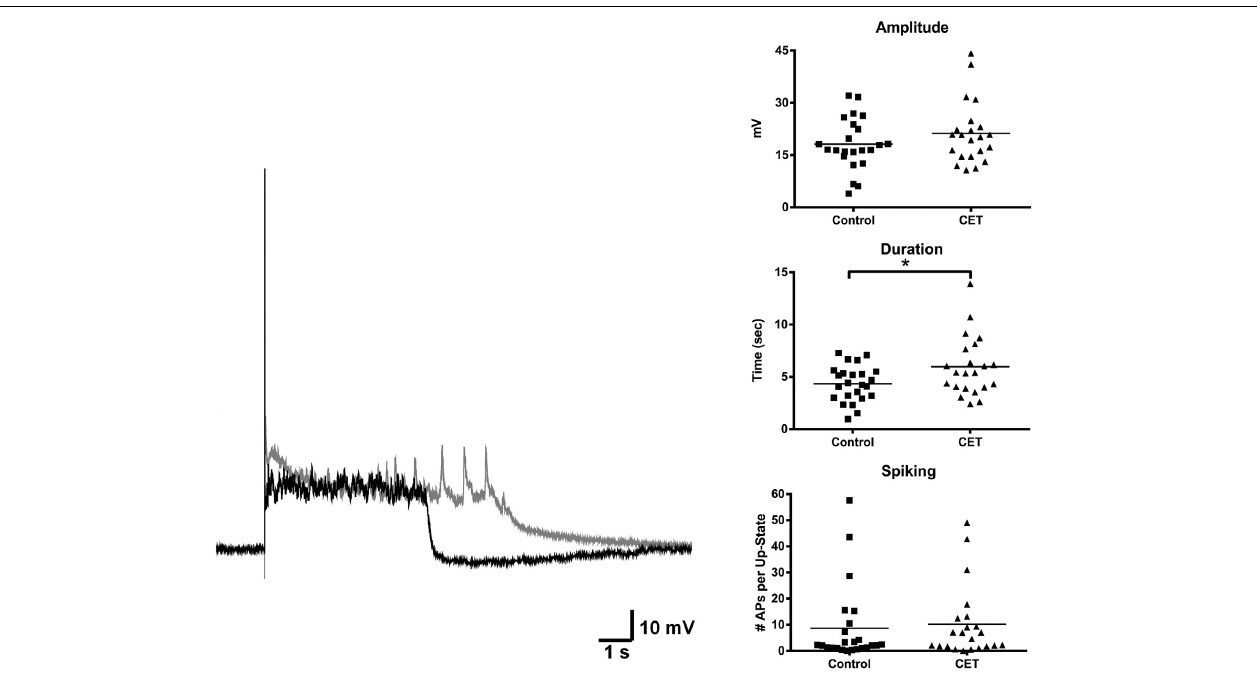
FIGURE 1 | Up-state duration is increased in cultures after withdrawal from chronic treatment with 44mM EtOH. Example traces: black trace is a representative example of an up-state from a control treated culture and gray trace is an example from a chronic